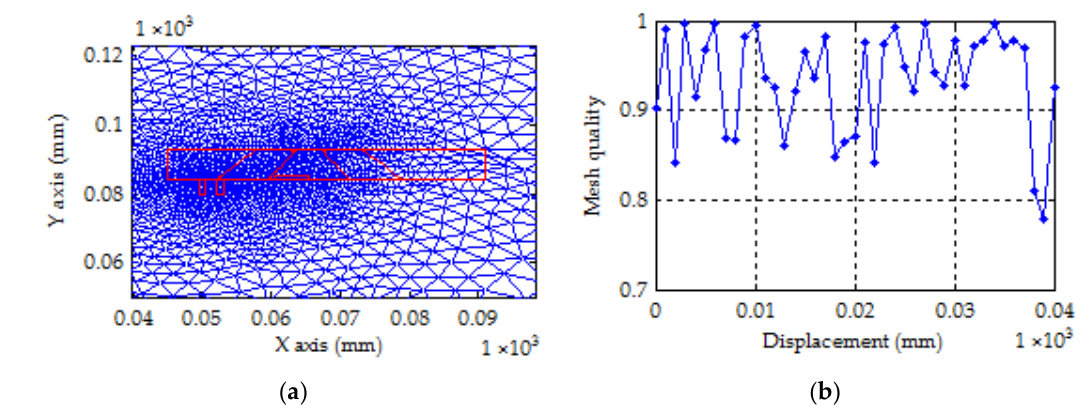
Figure 6. ( a ) Mesh of the solving domain and ( b ) Mesh quality according to the displacement.